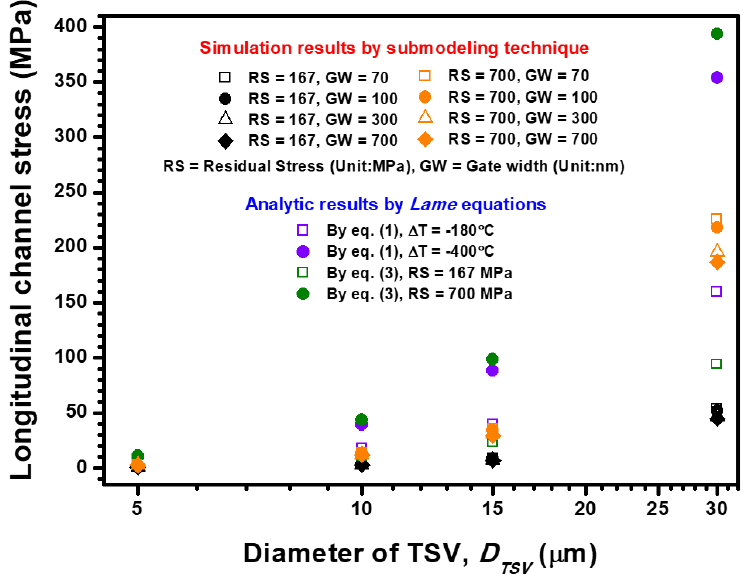
Figure 6. TSV-diameter, TSV-residual stress magnitude and channel gate width dependence longi- tudinal channel stress estimation (stress along the channel length direction) by using the analytical formula, semi-empirical formula and FEA submodeling simulation.